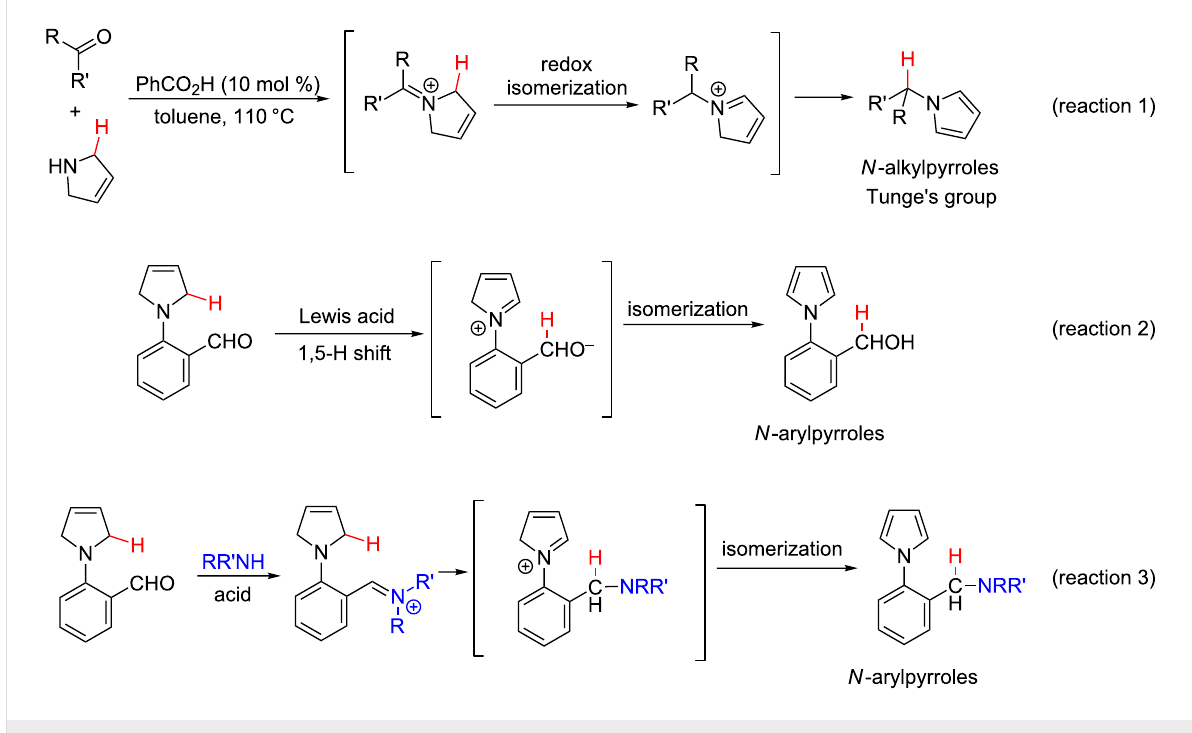
Scheme 1: Synthesis of N-substituted pyrroles via redox-neutral